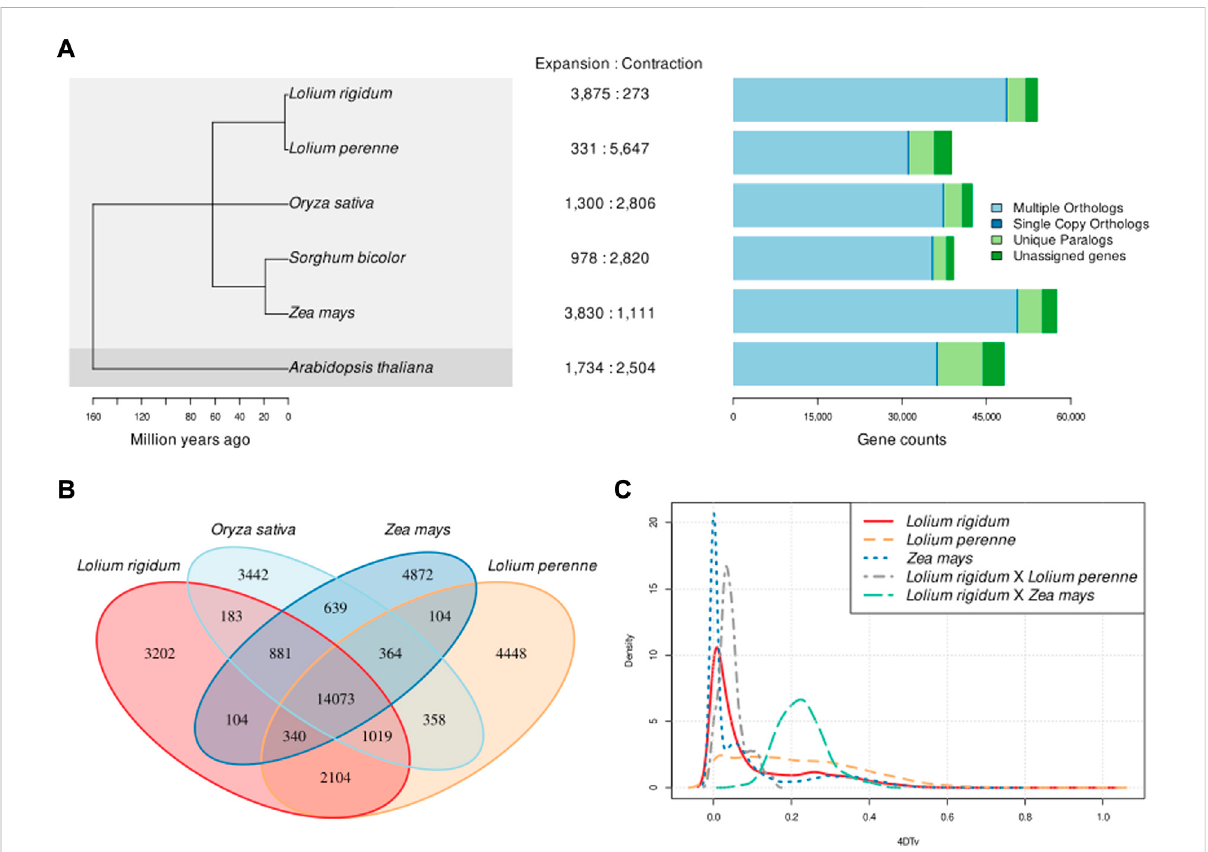
FIGURE 2 Loliumrigidum comparativegenomics.( A) (left):phylogenybasedonsingle-copygeneorthologs(100%bootstrapsupportacrossallclades);( A) (centre): number of signi fi cantly expanded and contracted gene families; ( A) (right): distribution of genes with multiple orthologs, single-copy orthologs and unique orthologs, (B) Venn diagram of shared gene families between L. rigidum , L. perenne , O. sativa , and Z. mays ; (C) distribution of the transversion rates in four-fold degenerate sites (4DTv) within orthogroups in L. rigidum , L. perenne and Z. mays